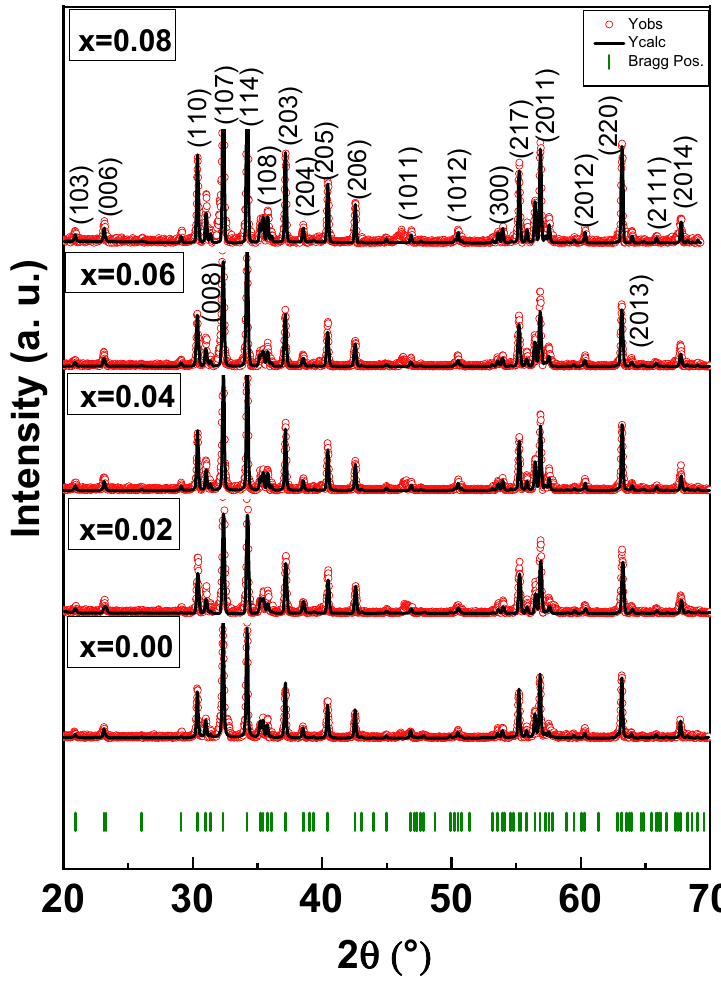
Figure 1. XRD powder patterns of SrNb x Fe 12 − x O 19 (0.00 ≤ x ≤ 0.08) HFs.